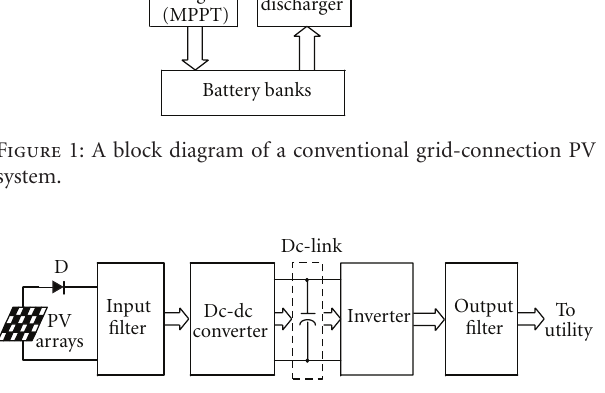
Figure 2: Illustration for a two-stage grid-connection PV system.